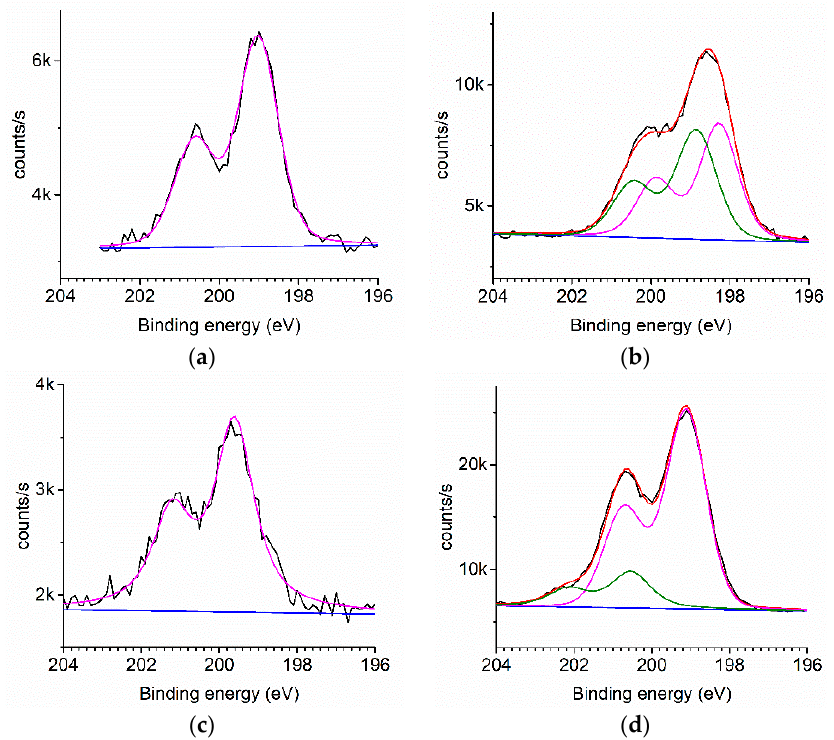
Figure 4. XPS Cl 2 p spectra for uncapped quartz samples showing fitted peaks: ( a ) Unsputtered Q7 500 c.; ( b ) unsputtered Q10 1000 c.; ( c ) Ar-sputtered Q7 500 c.; and ( d ) Ar-sputtered Q10 1000 c.